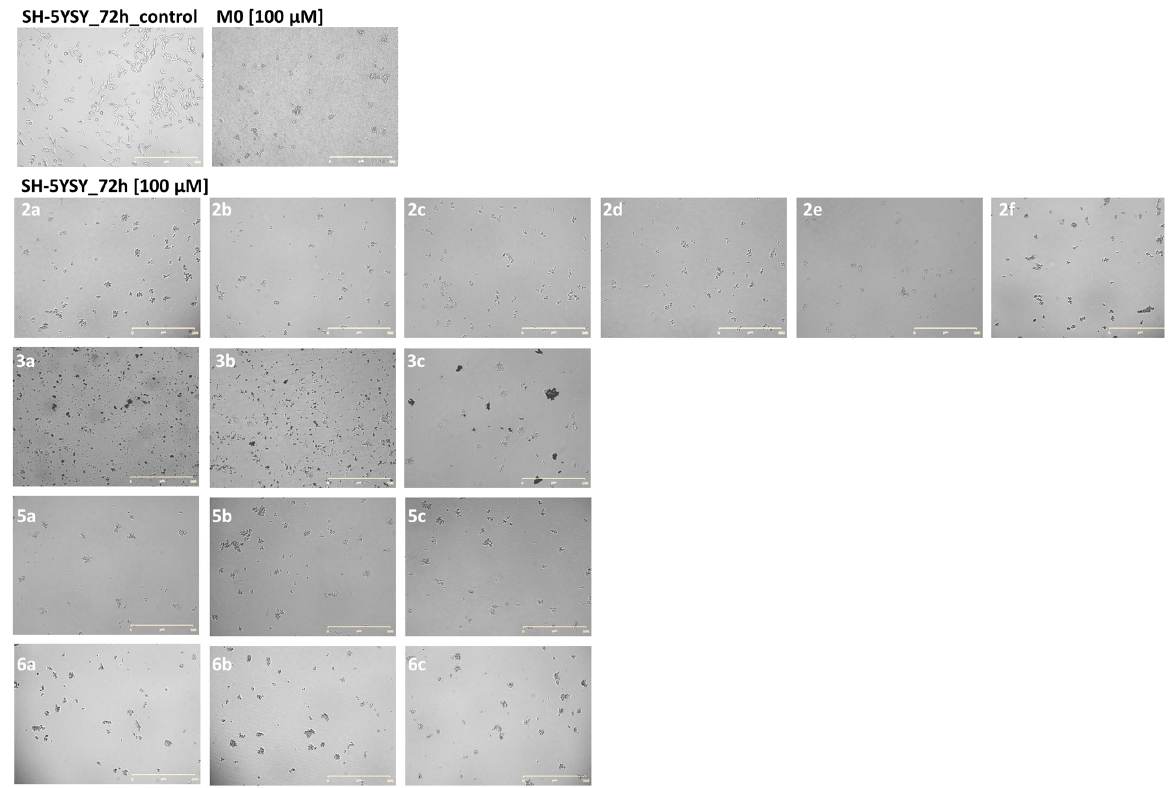
Figure 2. Typical images taken from SH-5YSY cells after 72 h of exposure to 100 µ M of tested compounds. Juli Fl apparatus (NanoEntek); magnification 4× g ; scale bar 100 μ m.